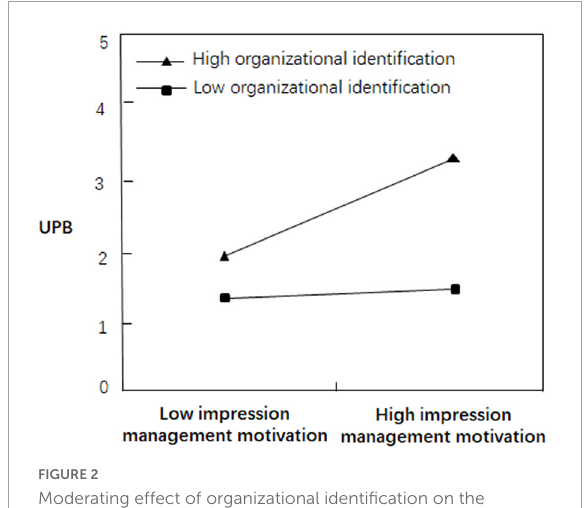
FIGURE2 Moderating effect of organizational identification on the relationship between impression management motivation and UPB.